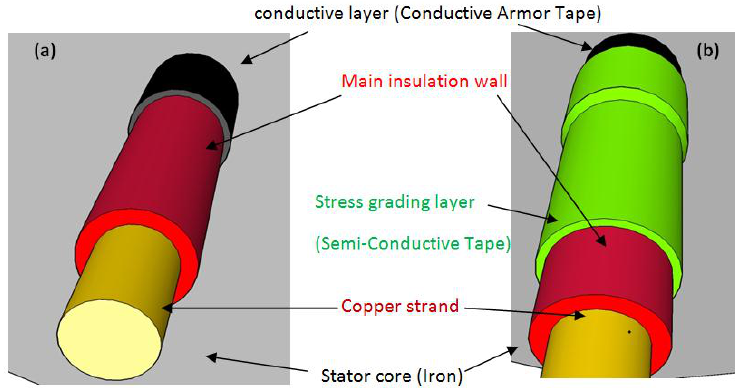
Figure 21. In both cases: ( a ) and ( b ); one strand surrounded by a main insulation wall exits from a stator core. A stress-grading layer in added in ( b ).